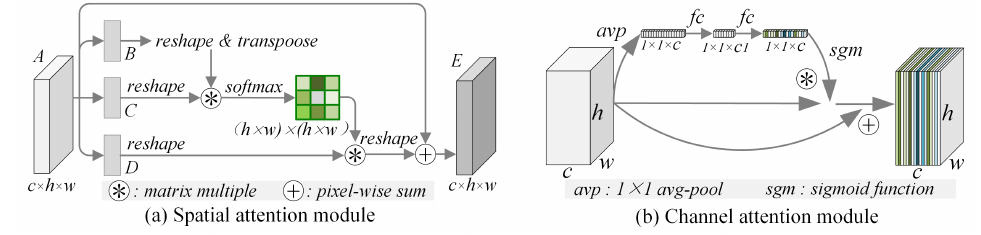
Figure 3. The detail of spatial attention module and channel attention module.